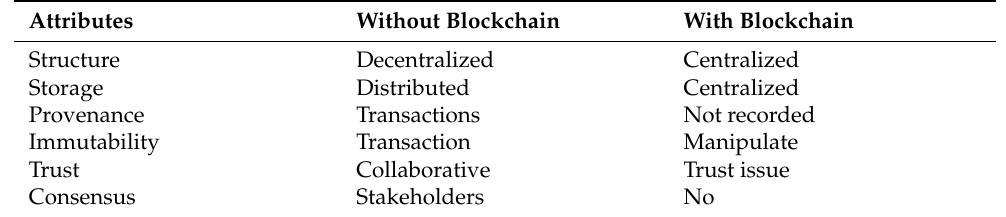
Figure 8. Comparison of packet delay between non-blockchain and blockchain-based techniques.